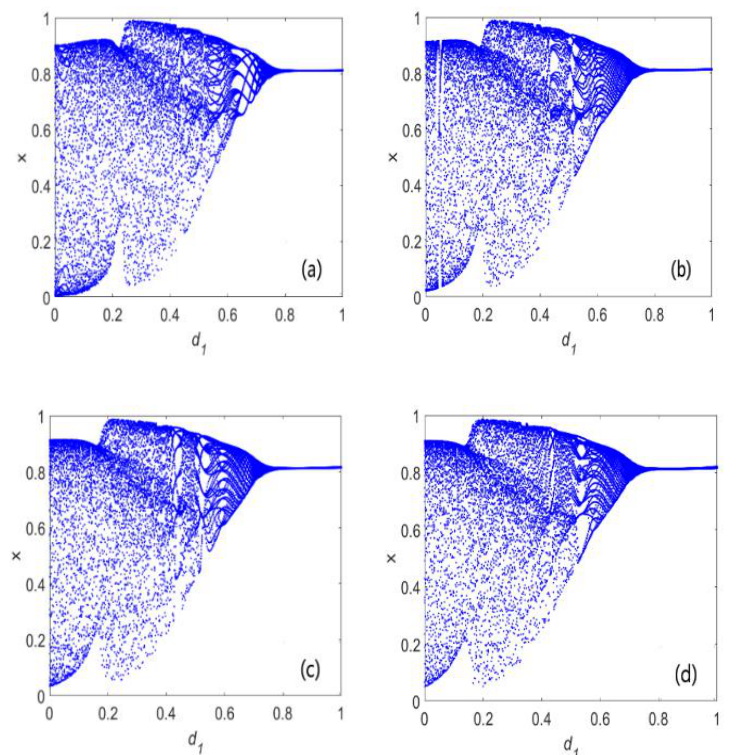
α = 0.985, ( b ) α = 0.97, ( c ) α = 0.96, 1 . ( a )